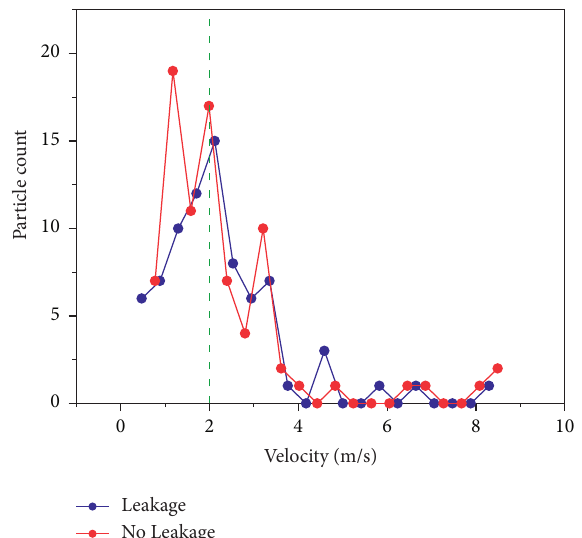
Figure 12: Distribution of particle velocity in the accumulation region of the first-stage impeller at 1.2s at Q � Q